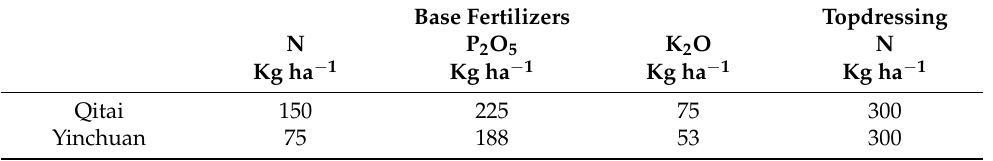
Table 1. Fertilizer application in maize growing season in Qitai and Yinchuan in 2018 and 2019. Base Fertilizers